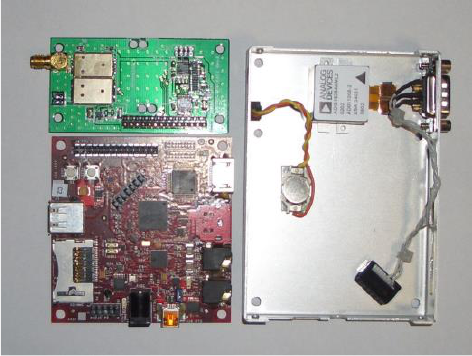
Fig. 2. Low cost RTK positioning developed by Takasu and Yasuda [1]